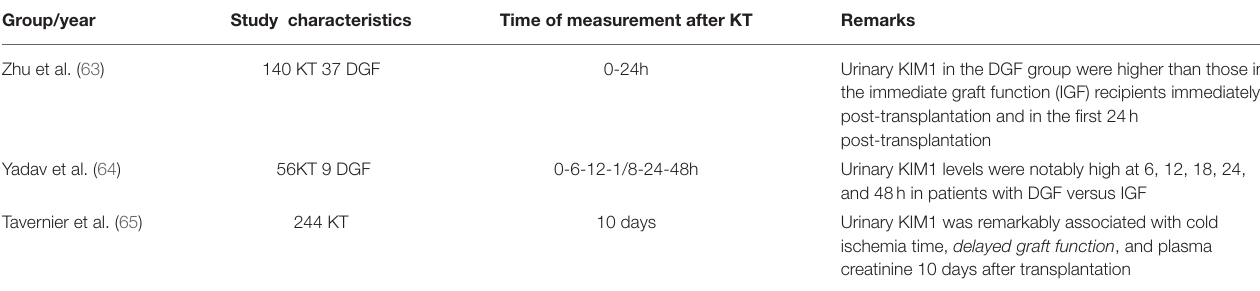
TABLE 3 | Comparison of studies on urinary KIM1 for the diagnosis of DGF after kidney